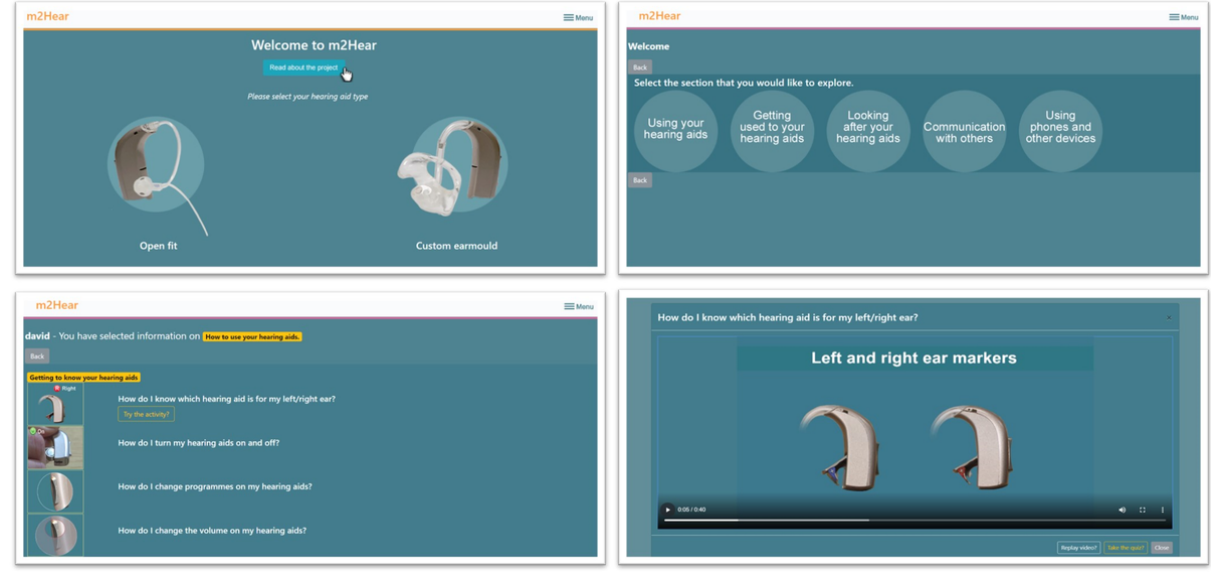
Figure 2. Screenshots of the m2Hear intervention, which is a freely available web-based intervention.